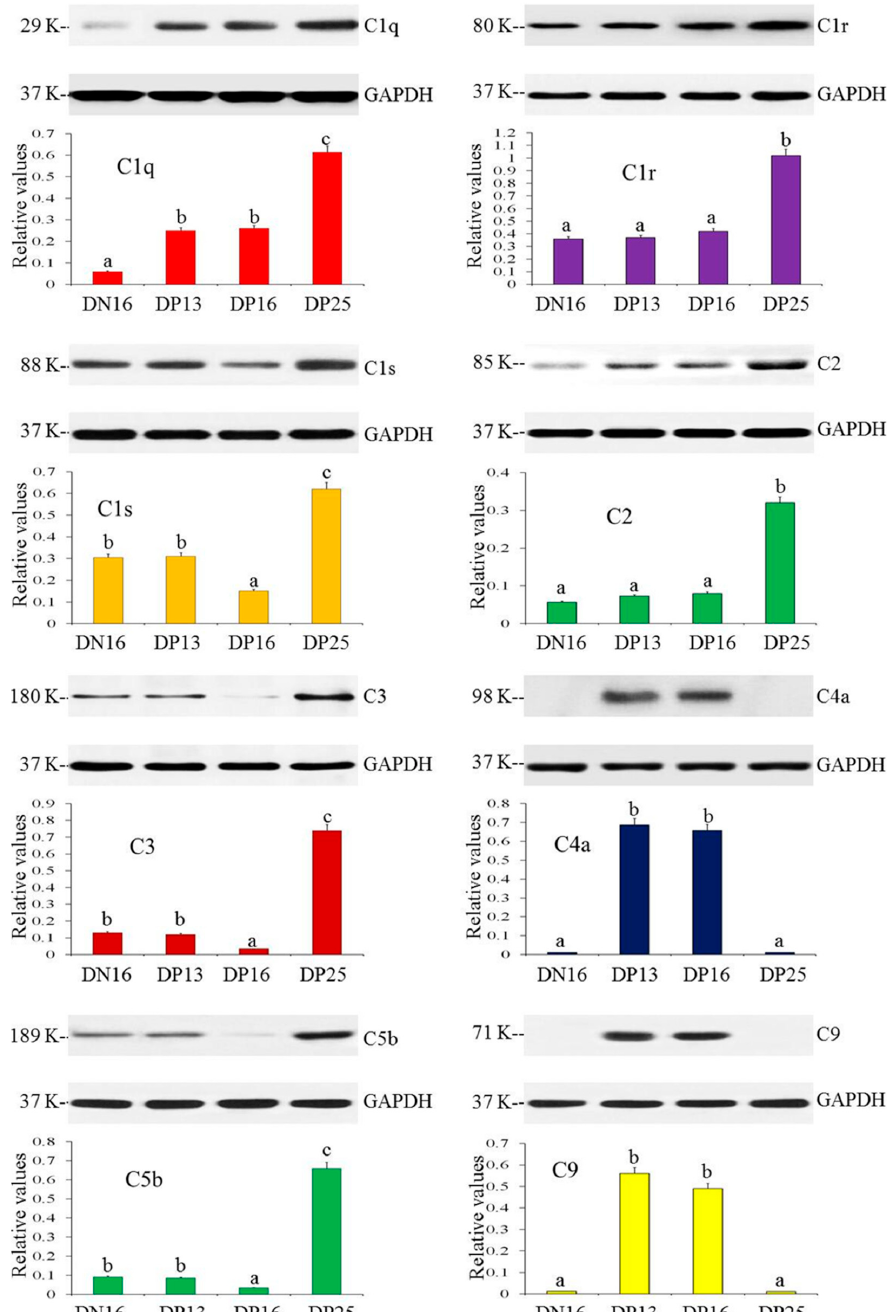
Figure 2. Protein expression of complement components in the spleen. Note: DN16 = day 16 of the estrous cycle; DP13 = day 13 of gestation; DP16 = day 16 of gestation; DP25 = day 25 of gestation. Significant differences ( p < 0.05) are indicated by different letters.